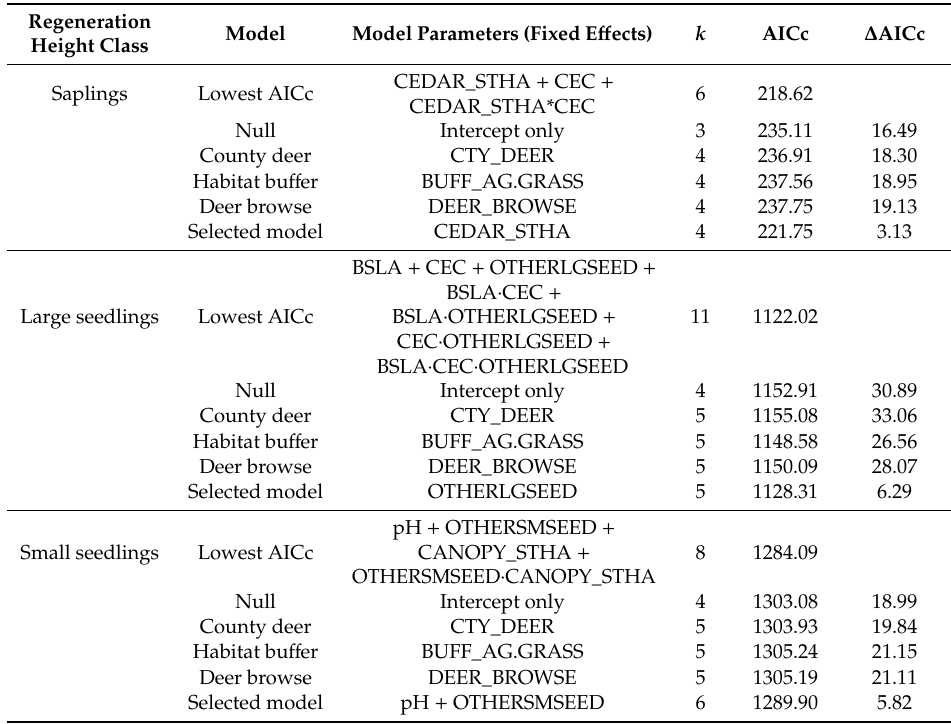
Table 3. Comparison of models for white-cedar regeneration density by height class created using the predictors selected by VSURF; k is the number of parameters, AICc is Akaike information criterion corrected for small sample size, and ∆ AICc is the di ff erence in AICc from the model with the lowest value. This table includes the model with the lowest AICc, the null model that includes only random e ff ects (site for saplings, plot nested within site for large and small seedlings), three models of deer e ff ects, and the model selected with ∆ AICc < 10.